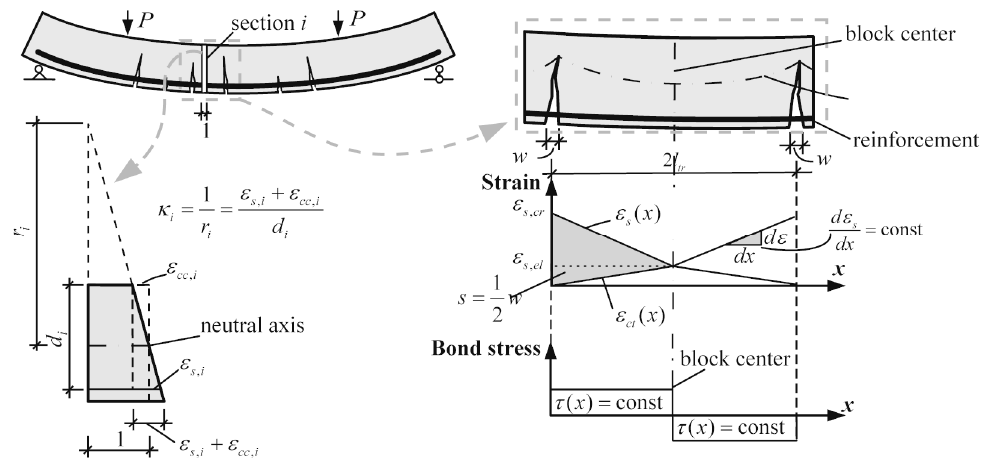
Fig. 2. Discrete crack approach in modelling a bending